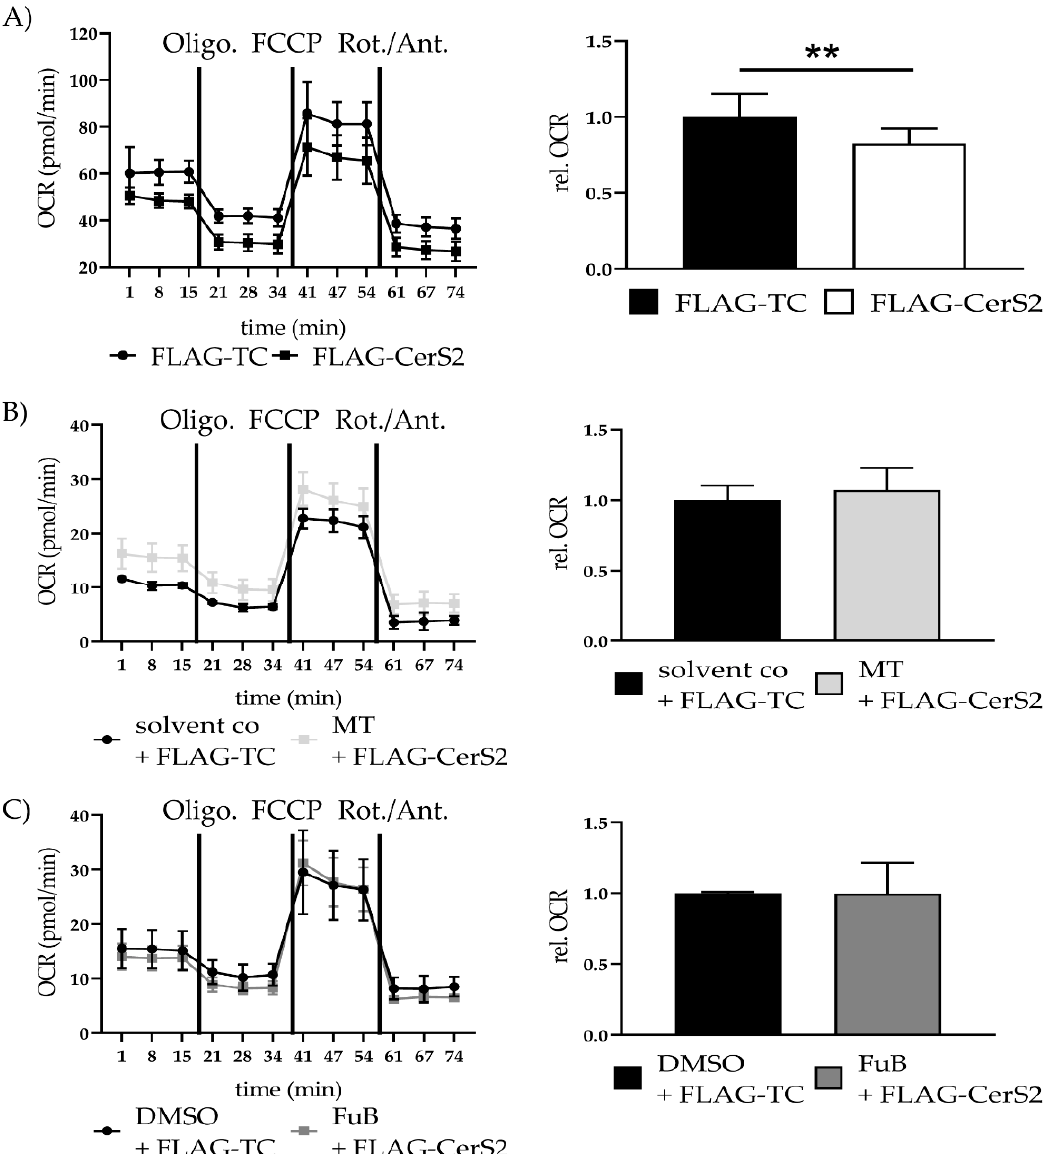
Figure 9. Mitochondrial Homeostasis—Metabolic function in FLAG-CerS2 determined with Seahorse Analysis. ( A ) Mitochondrial ATP production measured with Seahorse Analysis. Shown is one representative measurement. ( B ) Mitochondrial ATP production measured with Seahorse Analysis of FLAG-CerS2 hFSF pre-treated with MT. Shown is one representative measurement ( C ) Mitochondrial ATP production measured with Seahorse Analysis of FLAG-CerS2 hFSF pre-treated with FuB. Shown is one representative measurement. Depicted are mean values and standard deviation of minimum three biological replicates. Significances were calculated with a t -test. ** = significant to FLAG-TC. (** p ≤ 0.01). Cytochrome C was detectable in the cytosol of FLAG-CerS2 (17.2 ± 0.24, p < 0.001) (Figure 10A). MT and FuB preincubation reduced Cytochrome C to a normal